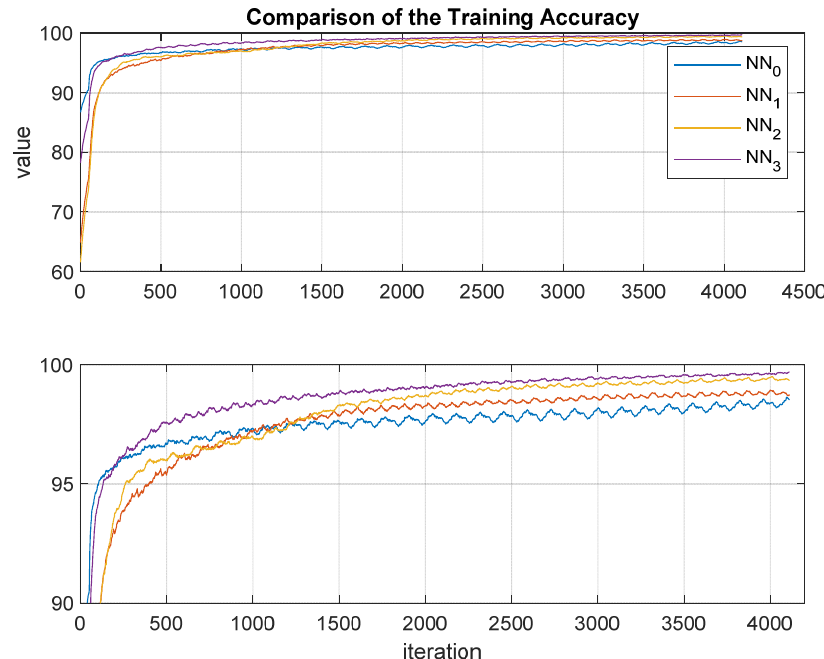
Figure 13. Accuracy behaviors comparison during training phase.